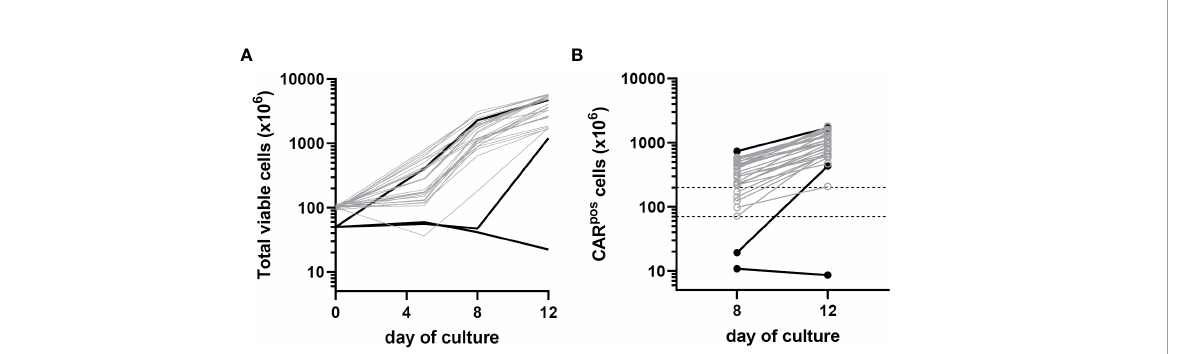
FIGURE 2 Growth kinetics of patient CLIC-1901 CAR-T cell products (n=30) manufactured using the CliniMACS Prodigy platform. CD4/CD8 T cells were enriched from bulk patient apheresis and either 50 million (black lines) or 100 million (grey lines) cells were used to initiate a 12-day culture using serum-free TexMACS medium and the ‘ enhanced feeding protocol ’ version of the TcT process. Cells were activated with TransAct immediately upon seeding and were transduced with lentivirus the following day. (A) shows the total number of viable cells present (measured on days 0, 5, 8 and 12) and (B) shows the number of CAR T-expressing cells present (measured on days 8 and 12). Dotted lines on (B) indicate the upper (200 × 10 6 ) and lower (1 × 10 6 /kg; average 70 kg) numbers of CAR-T cells required for standard dosage according to clinical protocol (10-fold lower doses are required for patients with high disease